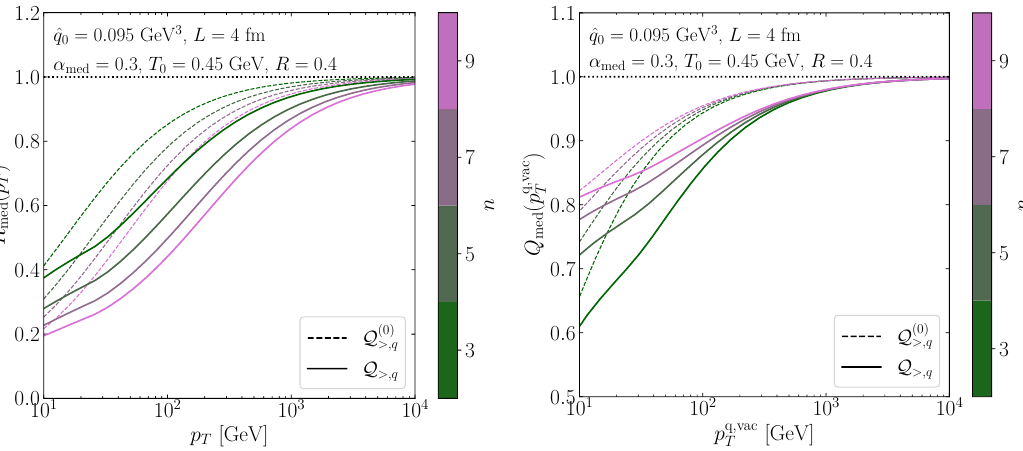
Figure 3 . The quenching factor (left) and the quantile ratio (right) for quarks only, using single par- ton quenching (dashed lines) and quenching the whole jet (solid lines) for different spectrum